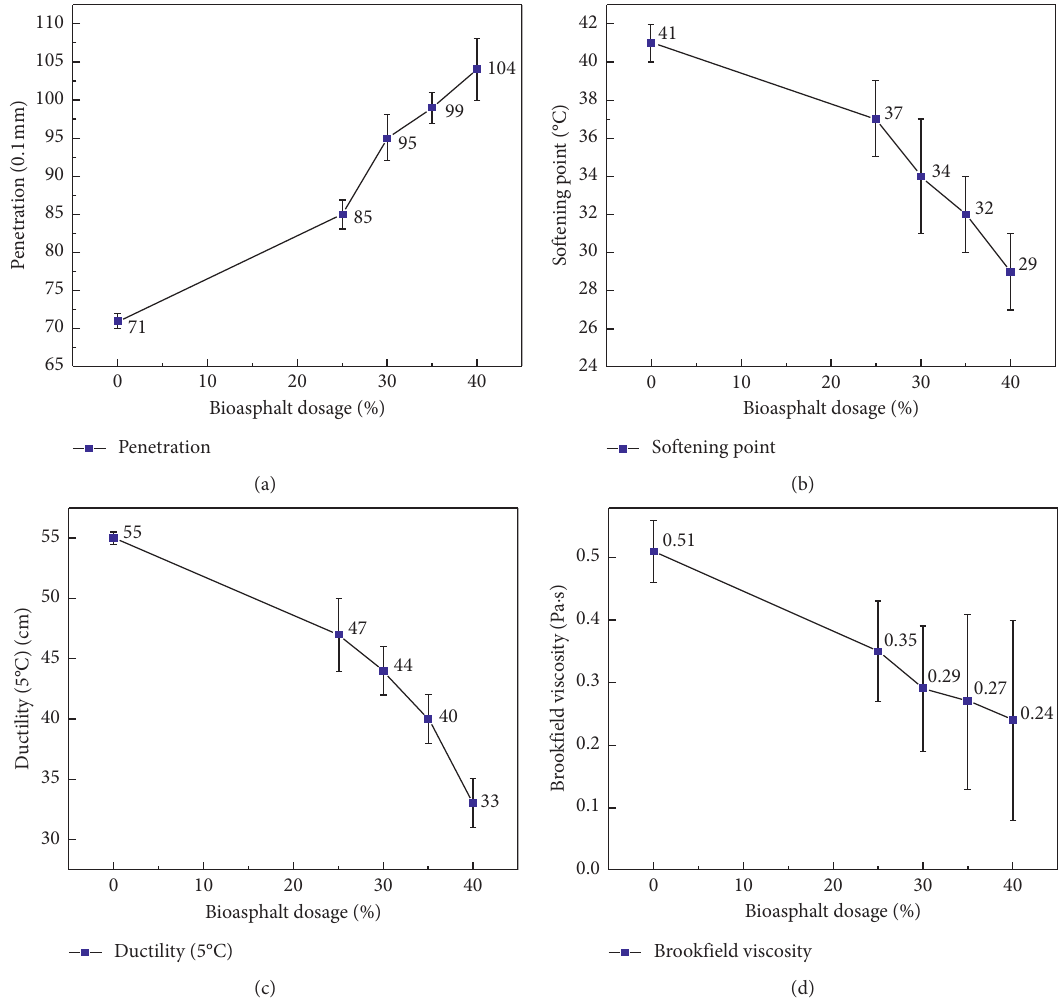
Figure 2: Single factor test results of bioasphalt variation. (a) Penetration test results. (b) Softening point test results. (c) Ductility test results. (d) Brookfield viscosity test